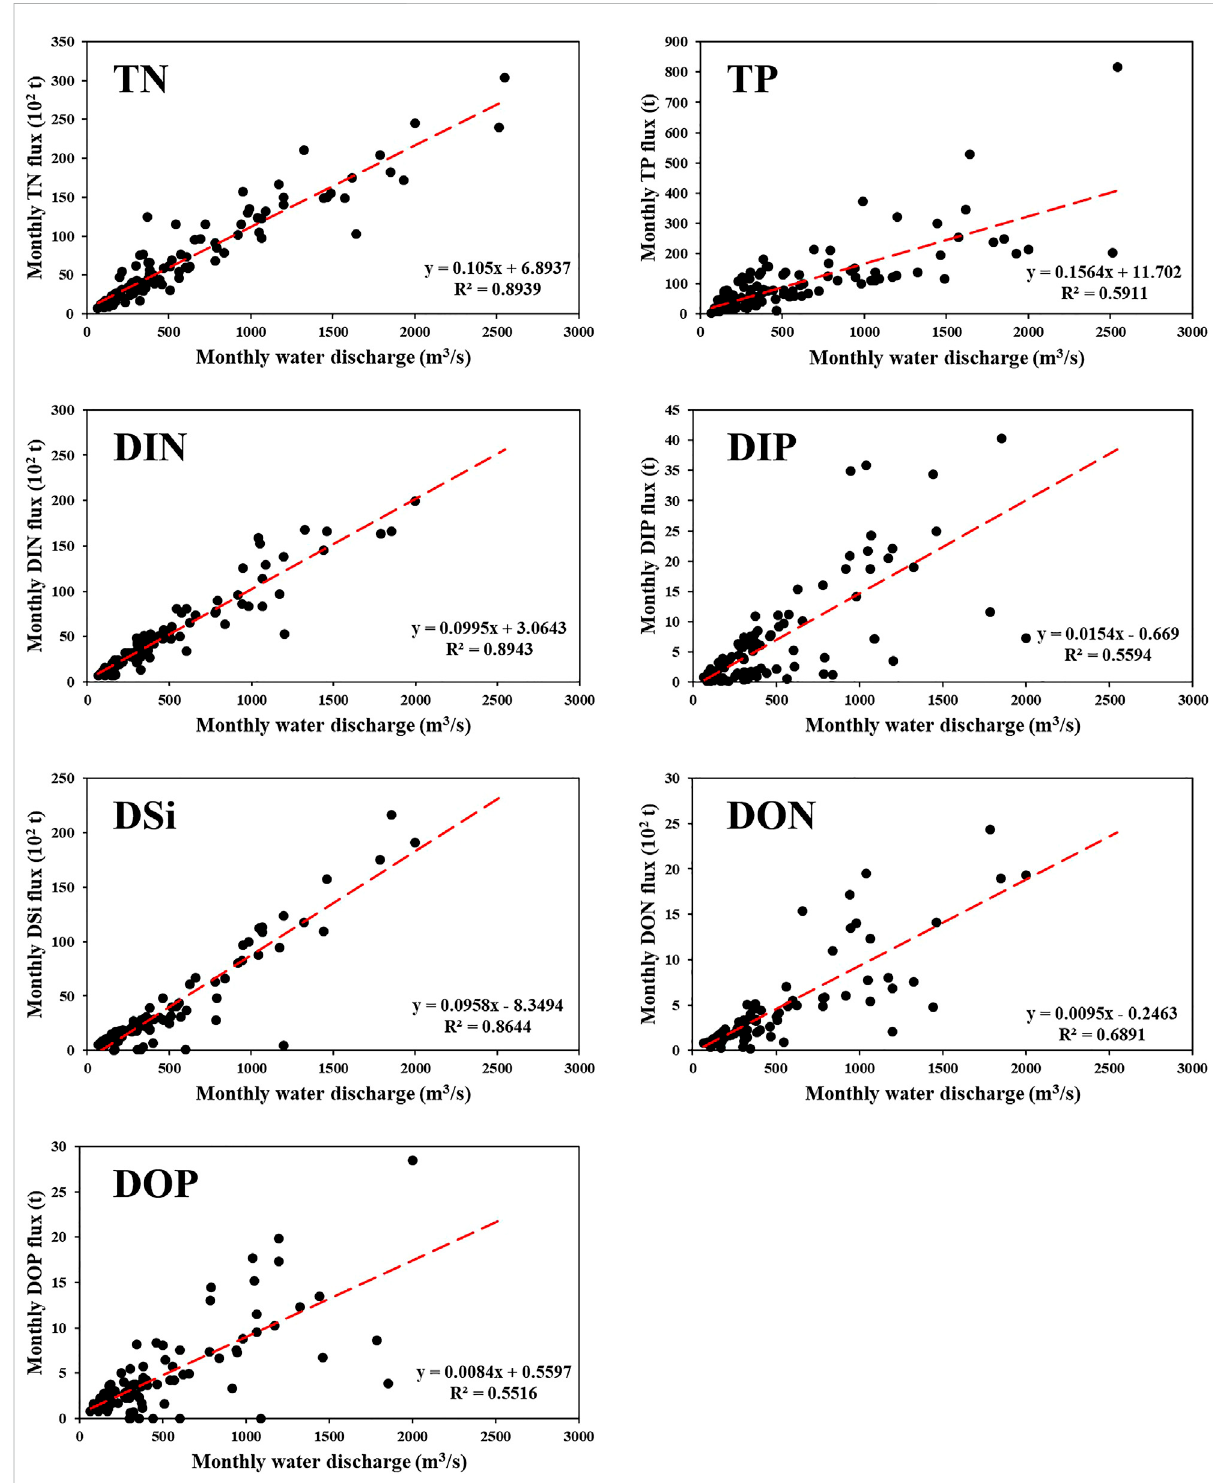
FIGURE 7 Correlations between monthly nutrient fl uxes and monthly water